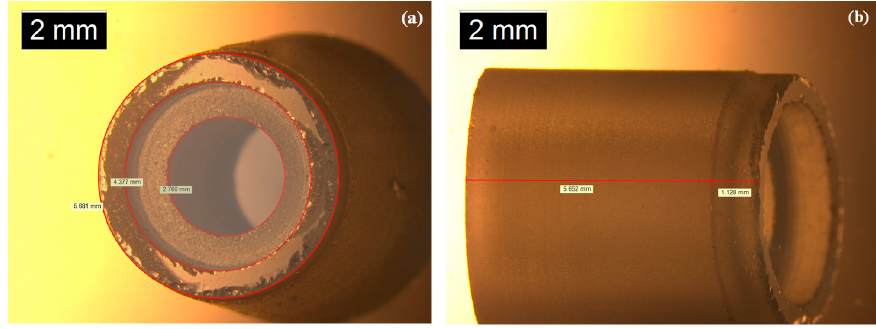
Figure 6. ( a ) Top view of a quartz tube. ( b ) Side view of a quartz tube.